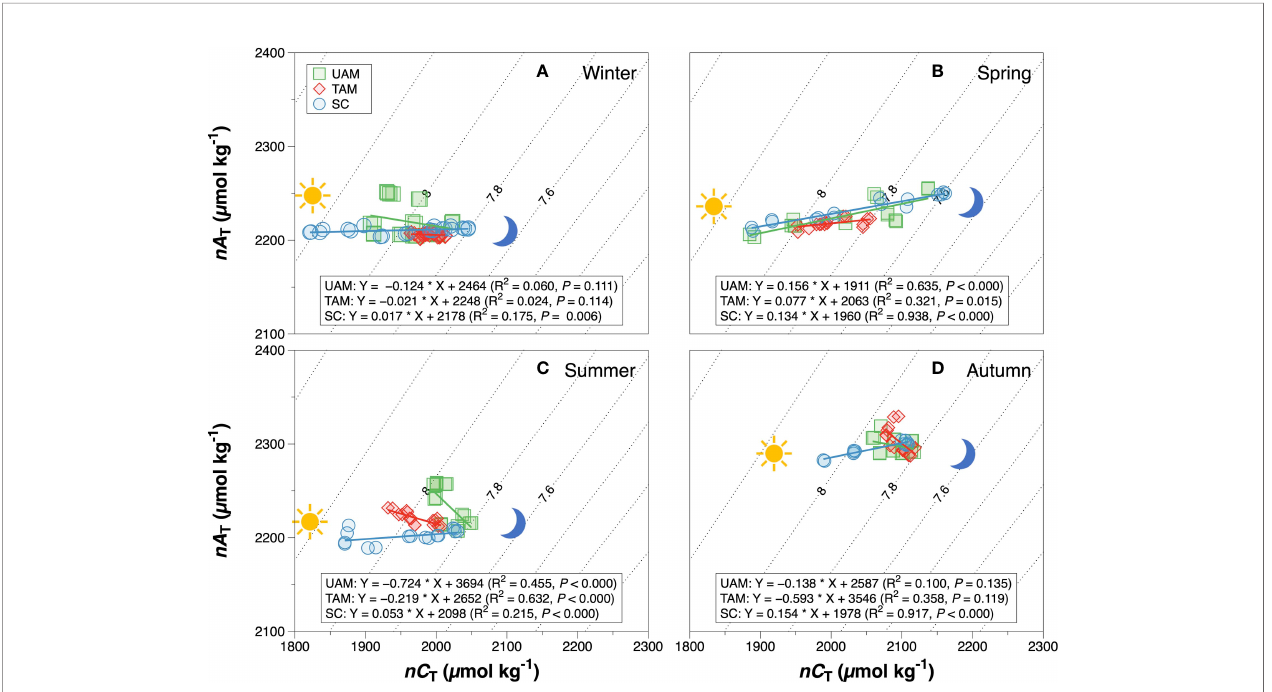
FIGURE 3 | The relationship between salinity normalized total alkalinity ( nA T ) and salinity normalized total inorganic carbon ( nC T ) at three macroalgal habitats with different macroalgal habitats in winter (A) , spring (B) , summer (C) and autumn (D) . The solid lines are the least square fi tting curve of data using the linear regression model. The dashed lines are pH isolines at 0.2 units increments with the 7.6 – 8.0 pH isoline indicated. pH contours were calculated using the averaged seawater temperature and salinity in each season. Values for different macroalgal habitats: ulvoid algal mat (UAM, green square); turf algal mat (TAM, red diamond); coexisting Sargassum horneri and crustose coralline algae (SC, blue circle).